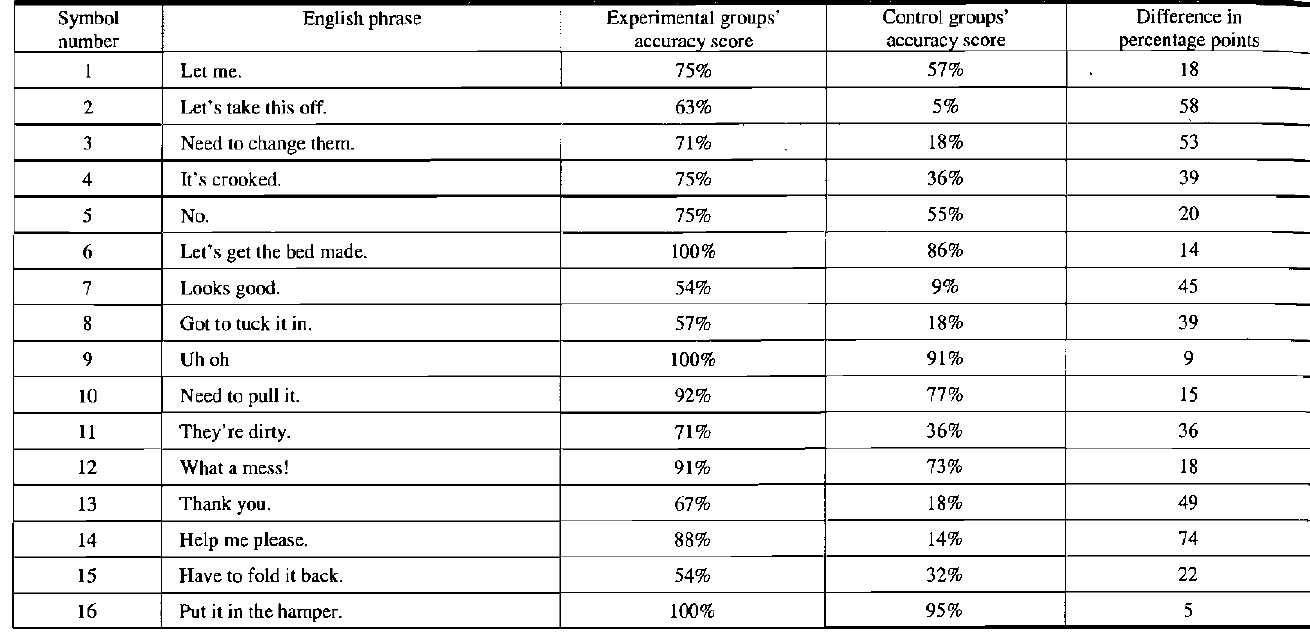
had an improvement of > 30 percentage points, 25% of the sym- bols had an improvement of between 10 and 30 percentage points, while 6.25% had an improvement of < 10 percentage points. Of the five symbols with a percentage point difference < 30, two symbols (symbols 6 and 9) did not improve further. The other three symbols' percentage point difference were > 25 per- centage points.